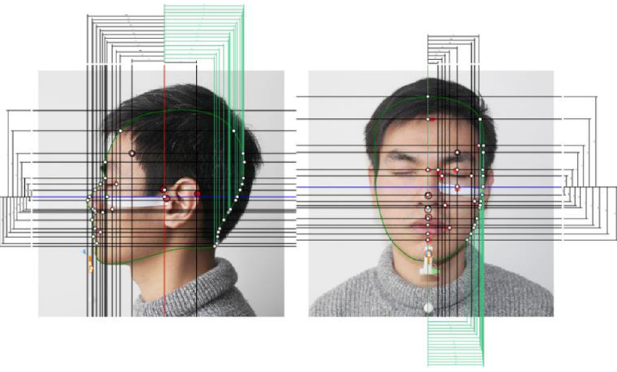
Fig. 12. Correct method for taking photographs.